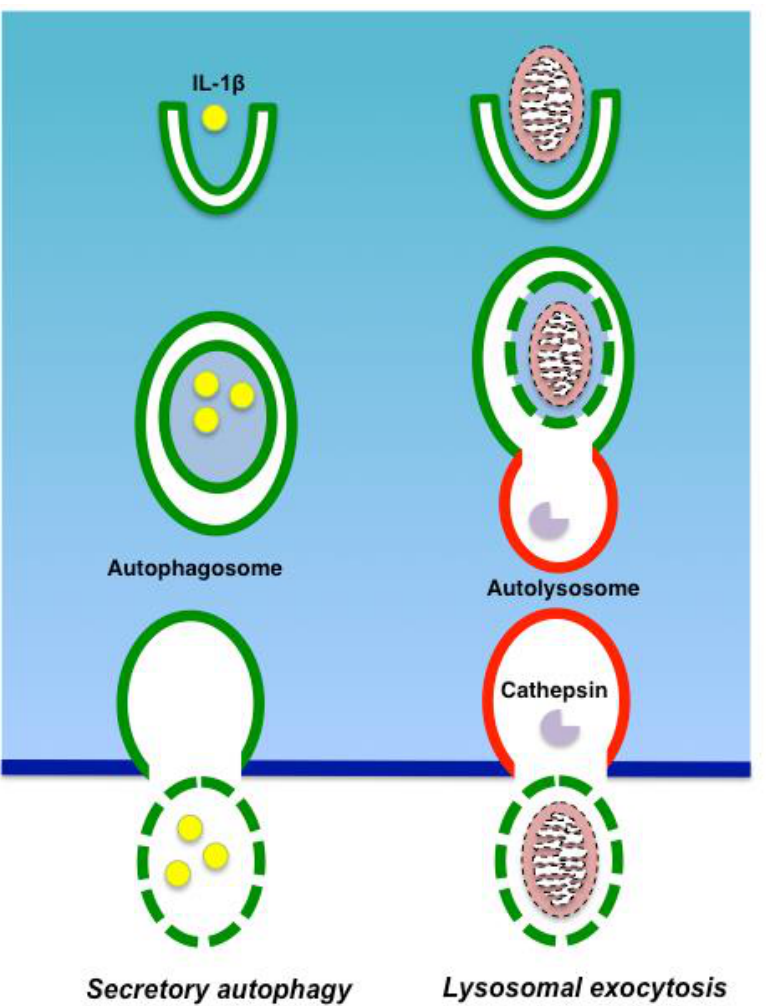
FIGURE 3: Secretion through autophagy machinery: secretory autophagy and lysosomal exocytosis. During secretory autophagy, autophagosomes do not fuse with lysosomes, but are delivered to the plasma membrane. During lysosomal exocytosis, autolysosomes fuse with the plasma membrane to extrude the con-